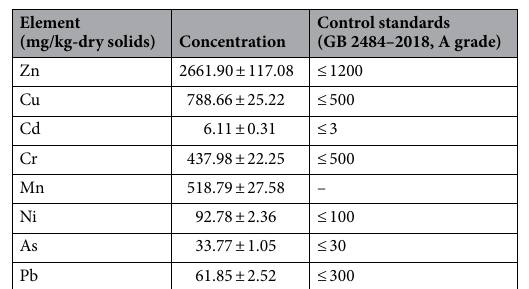
Table 1. Total concentrations of heavy metals in the raw